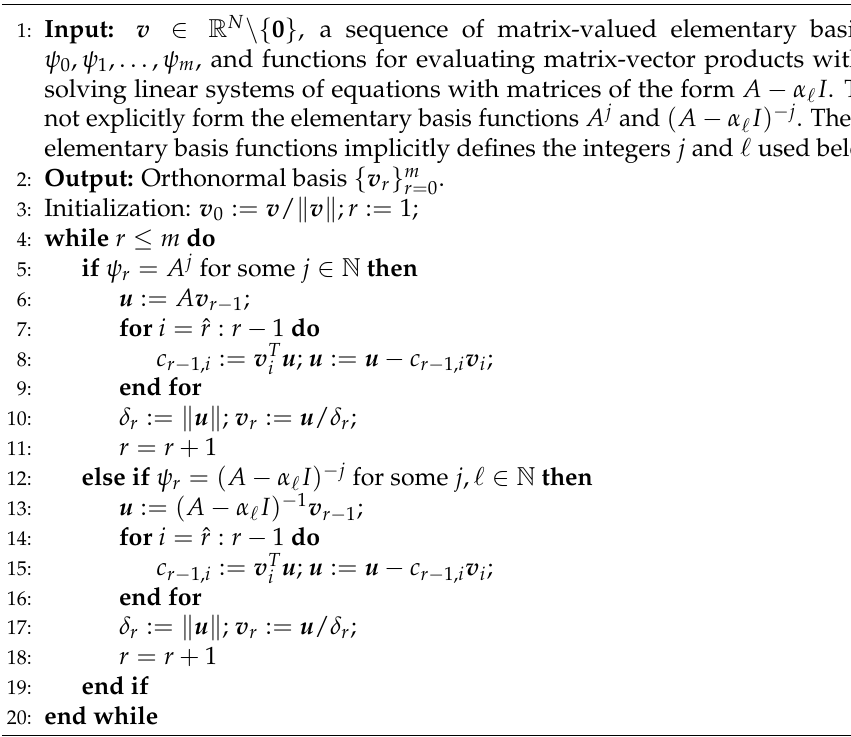
Algorithm 1 The rational Lanczos